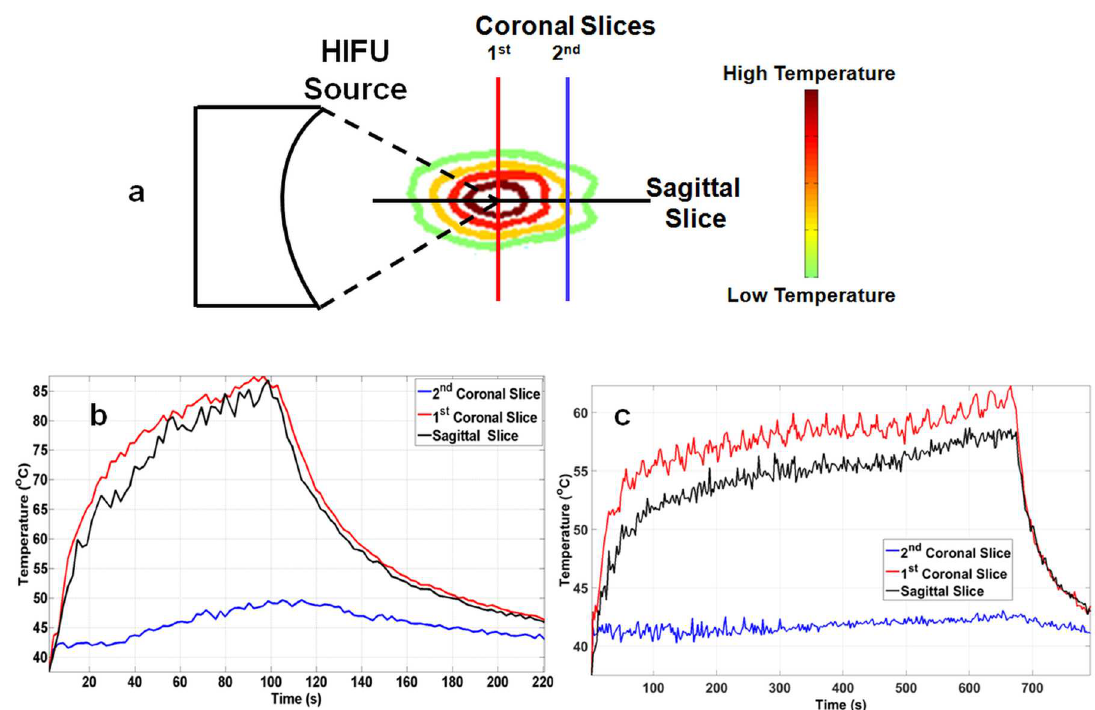
Fig 4. a . Illustration of temperature contours due to heat accumulating at focus. The positionof coronal and sagittal MRI thermometry slices at which real-time temperature measurements are made, is also marked. b . Sonication performed at 600 W of acousticpower, 4 Hz PRF, and 15,000cycles/pulse. Sagittal and first coronalslices had similar characteristics, reaching a peak temperature of 87˚C. The second coronalslice had a maximum temperature of 46˚C, throughoutthe entire sonication. c . Sonication performed at 600 W of acoustic power, at 1 Hz PRF for 684 seconds. Both first coronal and sagittal slices had similar temperature curve shapes, whilethe second coronal slice has marginalchangein temperature, with a peak temperature of 63˚C, 57˚C, and 43˚C